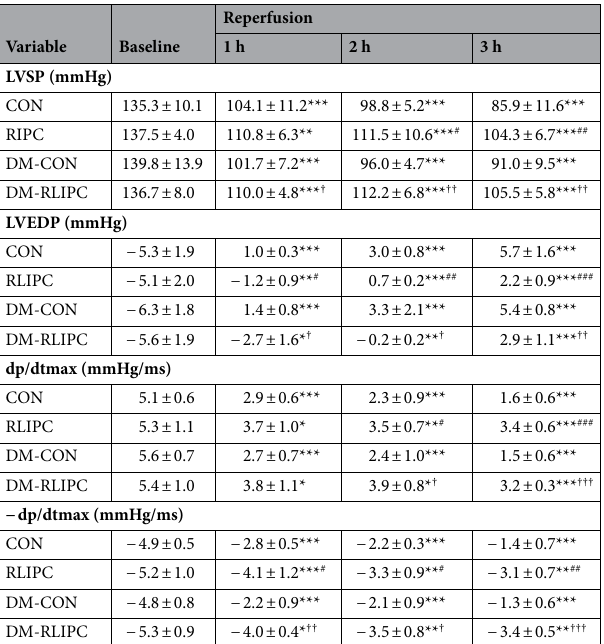
Table 1. The effect of RLIPC on hemodynamics. Data are expressed as mean ± SEM. CON: LAD occlusion only, RLIPC: remote liver ischemic preconditioning , DM: STZ-induced diabetes. LVSP = left ventricular systolic pressure, LVEDP = left ventricular end-diastolic pressure; ± dP/dtmax = maximum rate of increase/decrease in left ventricular pressure. n = 6 in each group. * p < 0.05, ** p < 0.01, *** p < 0.001 versus baseline, # p < 0.05, ## p < 0.01, ### p < 0.001 versus CON, † p < 0.05, †† p < 0.01, ††† p < 0.001 versus